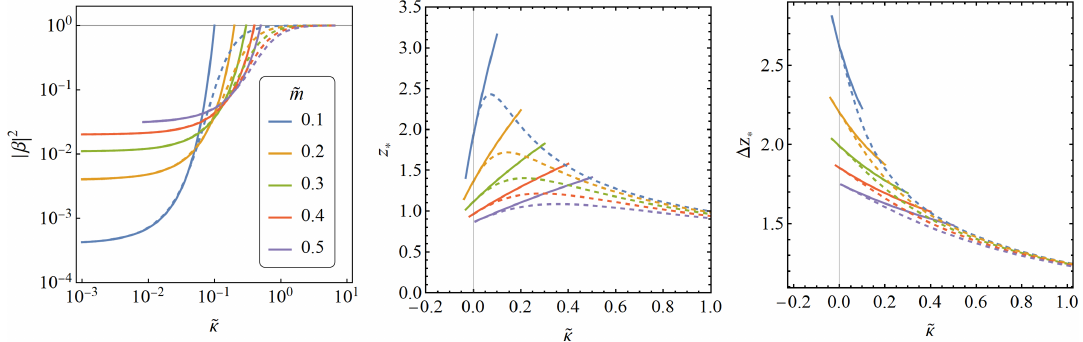
Figure 26 . The production histories in matter-dominated era. Left panel: production amount as a function of the dimensionless chemical potential for different particle masses. Middle panel: the z -domain production time dependence on chemical potential and mass. Right panel: the z - domain production width. In all three plots, solid lines represent spin-1 bosons while dashed lines represent spin-1/2 fermions. Particles with different masses are distinguished by the colors of the lines according to the legend in the left panel. The parameter range is chosen according to figure